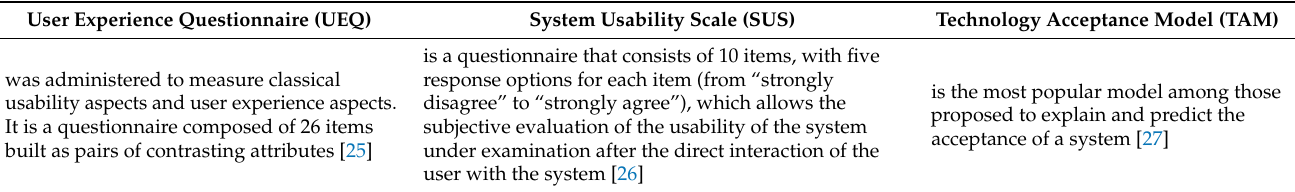
Table 5. Questionnaires used for the usability perception of the vCare